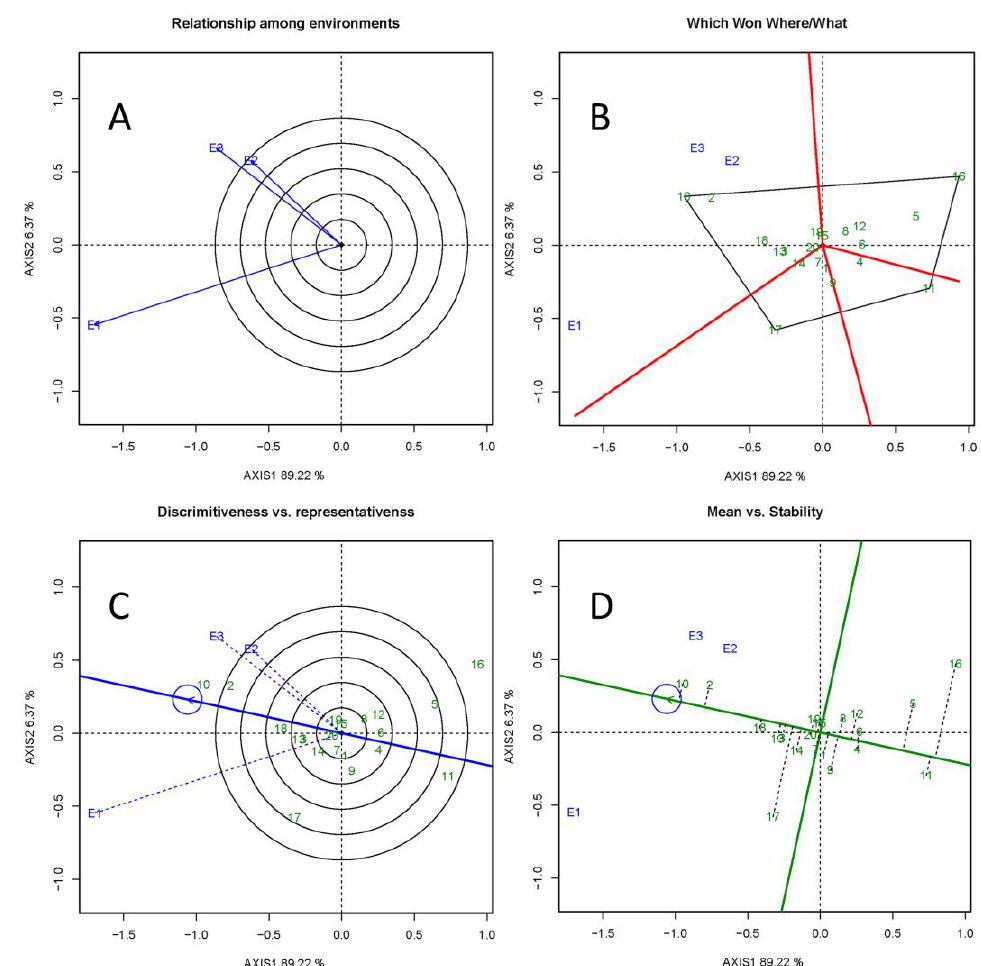
Figure 4. The GGE biplot based on the BLUP values of DBH at three sites. ( A ) Site relationships with the environmental view of the GGE biplot. The genetic correlation coefficient between sites is estimated based on the cosine value of the angle between two site vectors. When the angle is less than 90 ◦ , the smaller the angle, the greater the correlation coefficient. ( B ) The Which Won Where/What view of the GGE biplot. Optimal genotypes into an irregular polygon were connected and perpendicular lines through each edge of the polygon to the origin were drawn. Tested sites were grouped. Red solid lines intersecting at the sides of the polygon represent mega-environments. ( C ) The discrimination and representative view of the GGE biplot. The blue solid line with an arrow passing through the origin represents the average environment axis. Dashed blue vectors represent the discrimination of the site. The longer the vector, the greater the discriminatory power. The angle between the dashed vector and the average environmental axis illustrates the degree to which a given site represents the average environment. ( D ) The mean and stability view of the GGE biplot. The vertical black dashed line segment represents the productivity and stability of each clone. Shorter dashed lines represent better adapted clones. The green solid line perpendicular to the average environment axis represents the mean population DBH. The farther away to the left of the average environment axis, the greater the values of